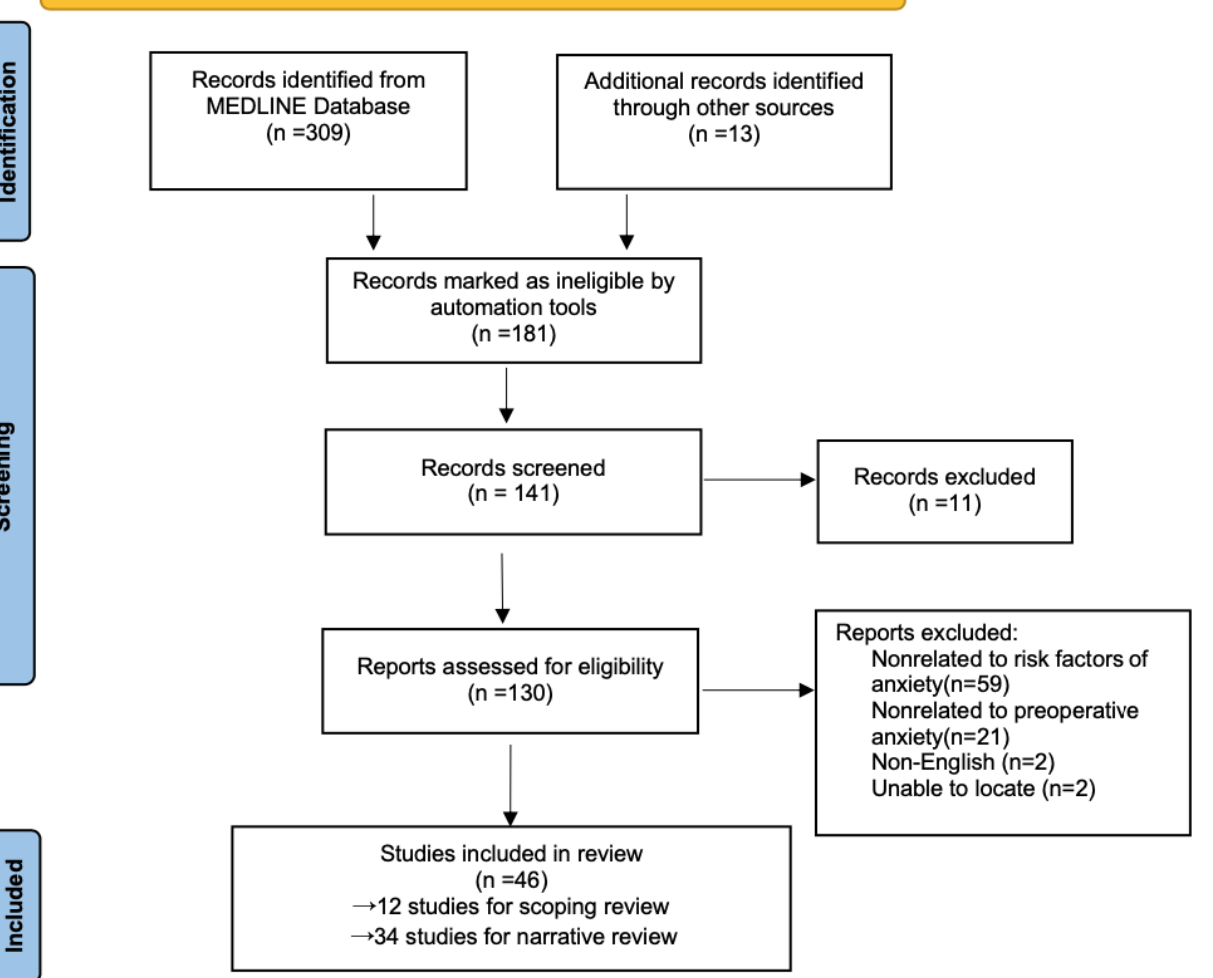
Figure 1. Flow of publication selection processes.